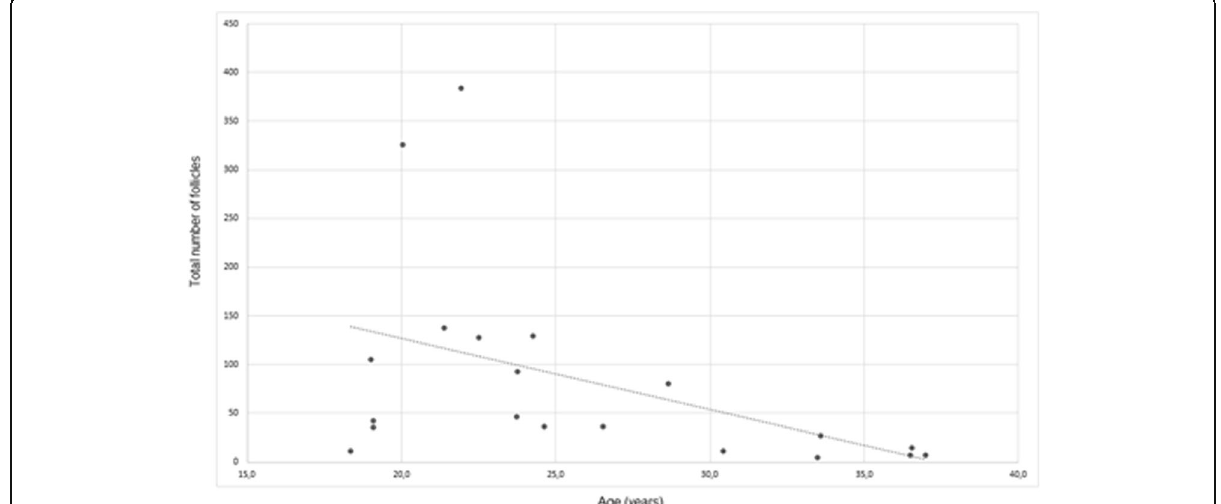
Fig. 3 Scatter plot of the total number of follicles versus age at